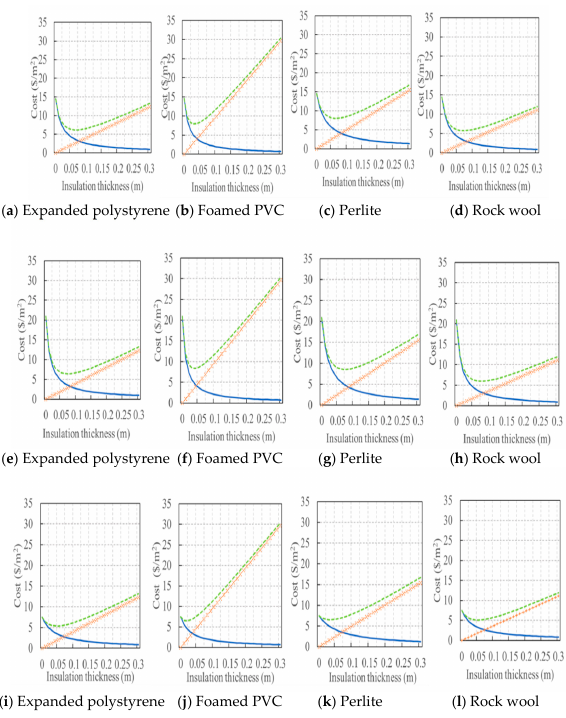
Figure 6. Effect of thickness of insulating materials on the total cost for three typical walls. ( a–d ) For the clay brick wall, ( e–h ) for the hollow concrete block wall, and ( i–l ) for the fly ash block wall. 3.3. Impact Factors on the Optimum Insulation Thickness Figure 7 illustrates the effect of thermal resistance of the composite wall on the optimum insulation thickness. The optimum insulation thickness will decrease linearly with the increase in R wt . For the insulating material of expanded polystyrene, perlite, and rock wool, the optimum simulation thickness was in the range of 0.1 – 0.2 m and was 0.05 – 0.1 m for that in the insulation of foamed PVC, with the R wt of 0.2 – 1.2 m 2 K/W. According to the result, the optimum insulation thickness can be proposed in Shenyang for these representative materials.